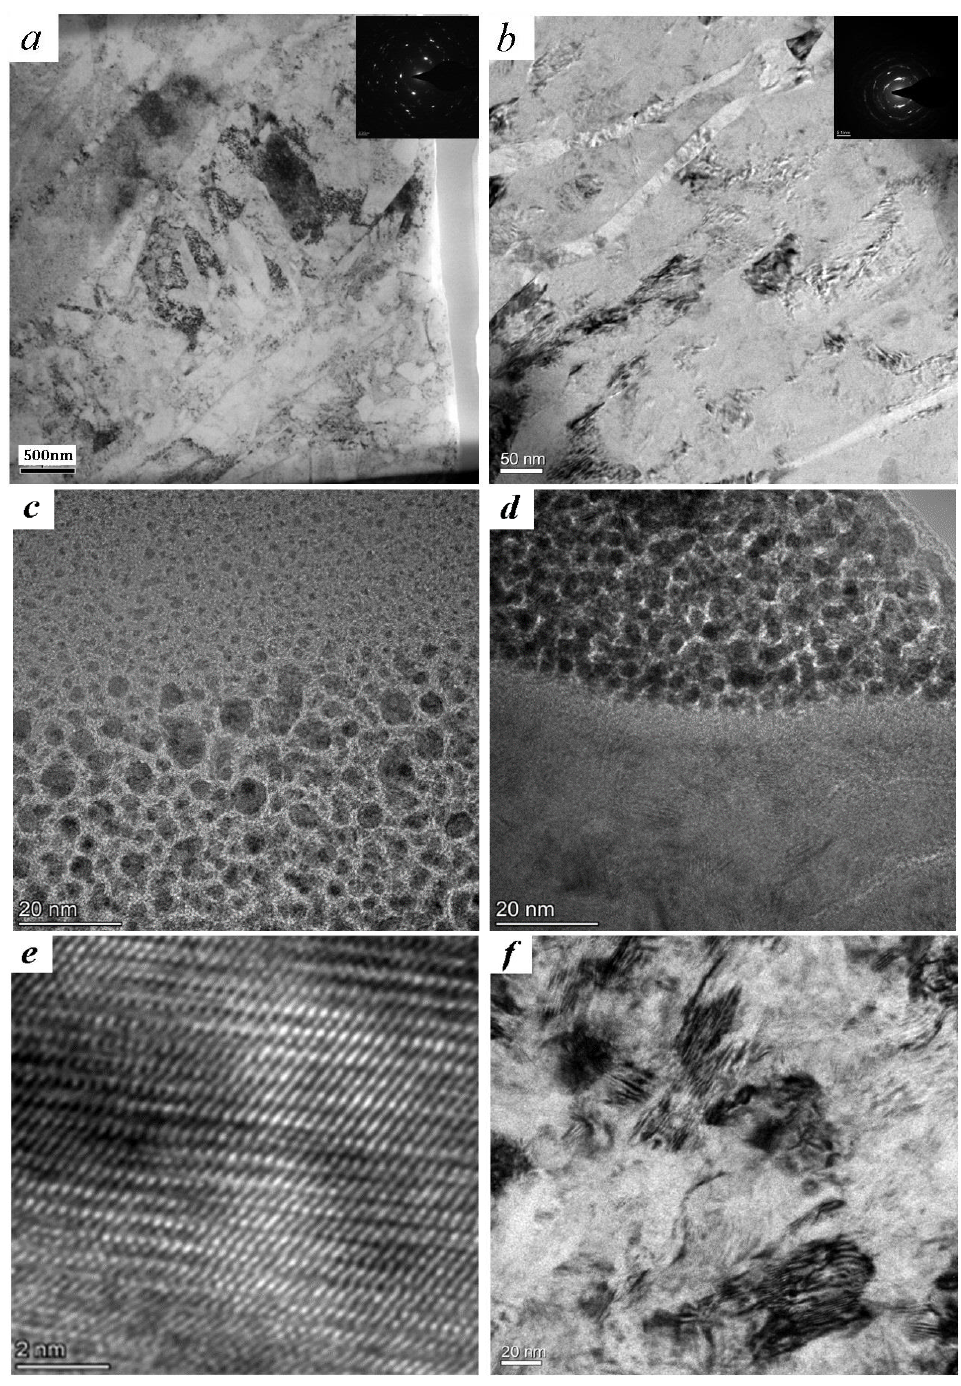
Figure 3. TEM observations: ( a ) image (depth of 3 μm) and diffraction pattern of TC4; ( b ) image (depth of 3 μm) and diffraction pattern of TLM; ( c ) image (depth of 1 μm) of TC4; ( d ) image (depth of 1 μm) of TLM; ( e ) the lattice image of Figure 3c; ( f ) the bright field image of TLM (depth of 4 μm).